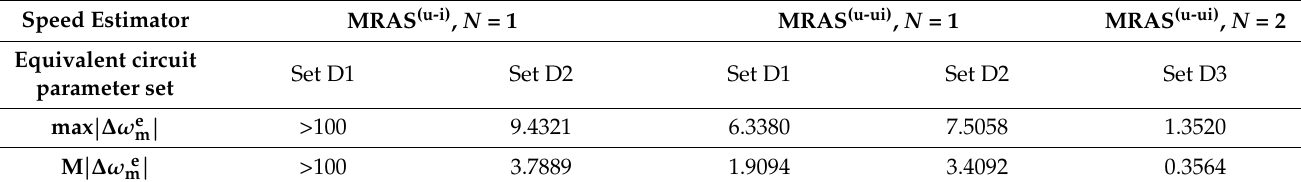
Table 2. Maximum and mean relative errors (%) of the speed estimation for the tested SR